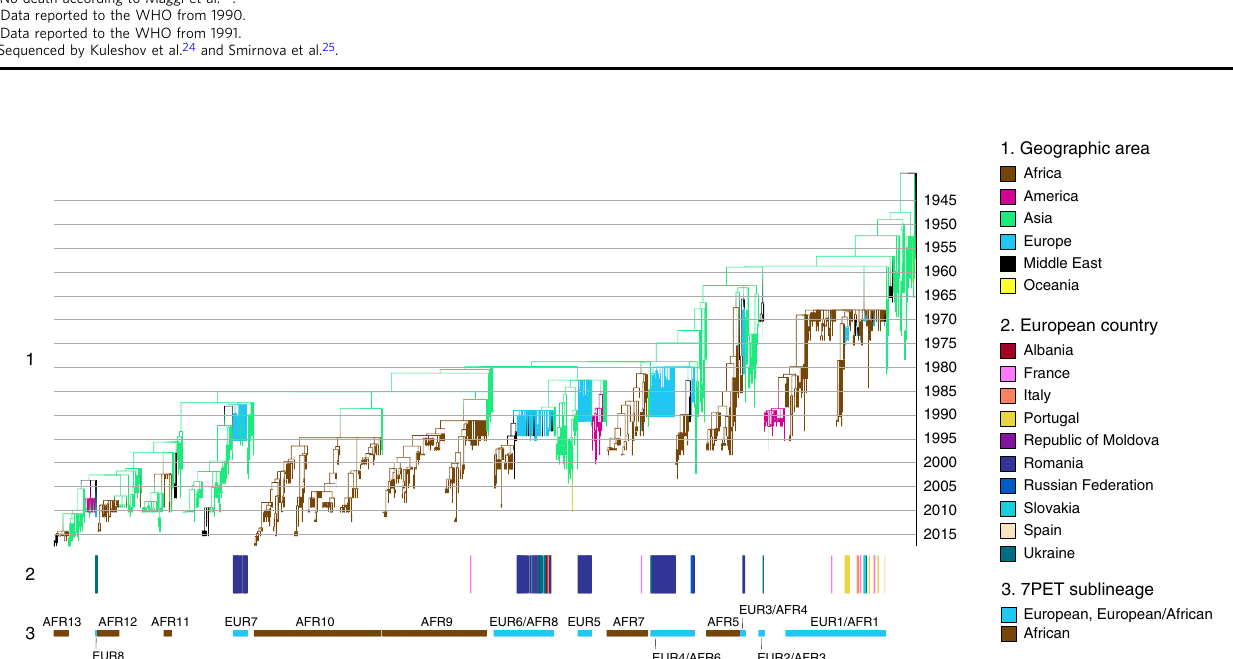
Fig. 1 Timed phylogeny of the seventh pandemic V. cholerae O1 El Tor isolates analyzed here. A6 was used as an outgroup. Using the 1,324 seventh pandemic V. cholerae O1 El Tor (7PET) genomic sequences, we identi fi ed 41 isolates as outliers (Supplementary Data 1), which were removed before the construction of this dated tree. (1) Branches are colored according to the reconstruction of the ancestral geographic locations of the isolates. Below the phylogeny (2) indicates the countries of origin of the European isolates and (3) indicates the 7PET sublineages